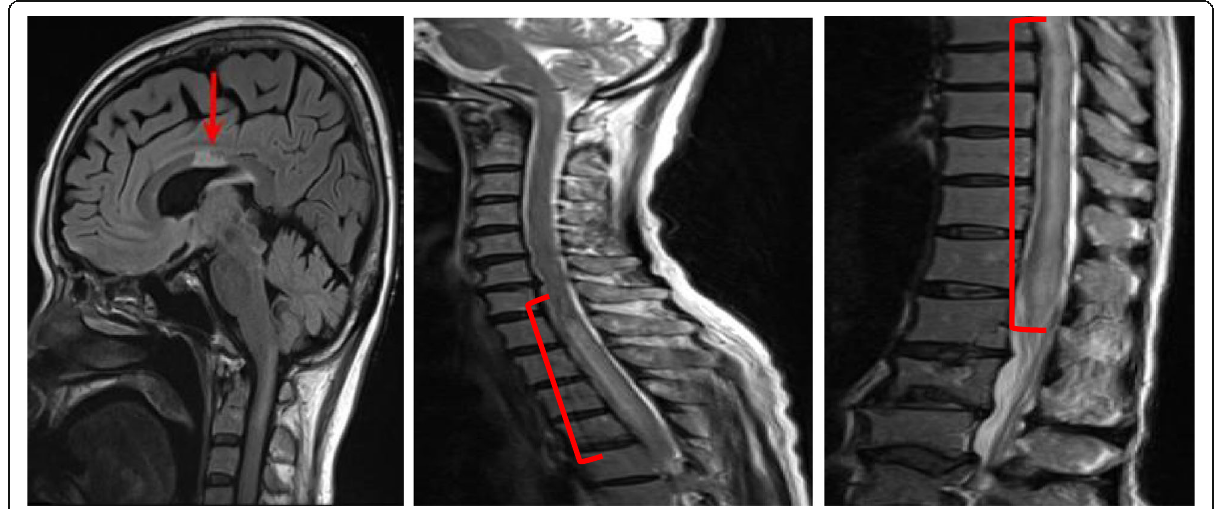
Fig. 2 MRI images of the patient ’ s head and spine. Flair (left panel) and T2-weighed (middle and right panels) images of the patient at the onset of transverse myelitis are shown